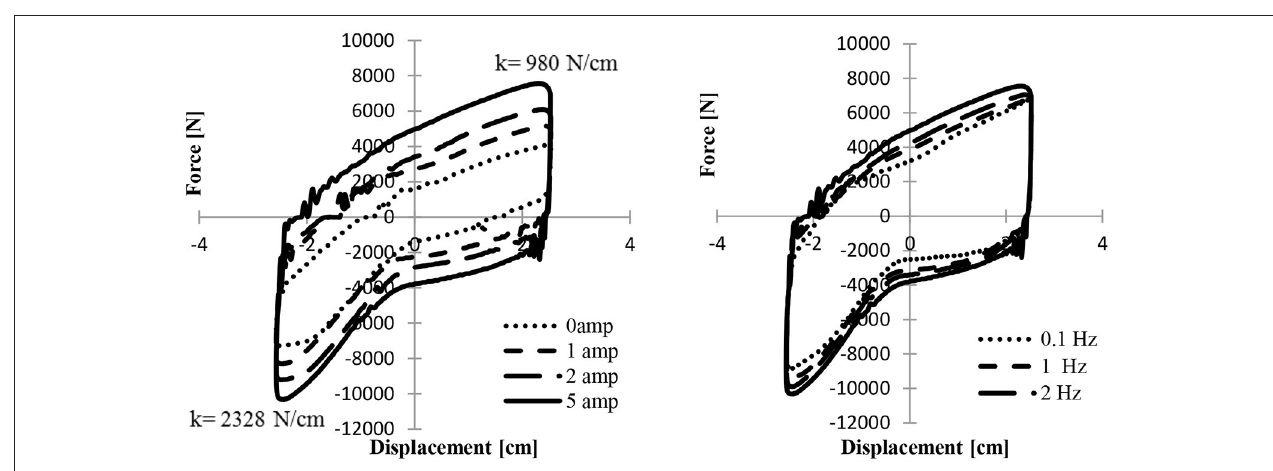
FIGURE 14 | (Left) Force displacement plots for BDLS-CMRD with a sinusoidal input of 2.5cm at 4Hz and 0, 1, 2, and 5 Amps illustrating the increasing MR effect. (Right) Force displacement plots for BDLS-CMRD with a sinusoidal input of 2.5cm at 0.1, 1, 2, and 4Hz.